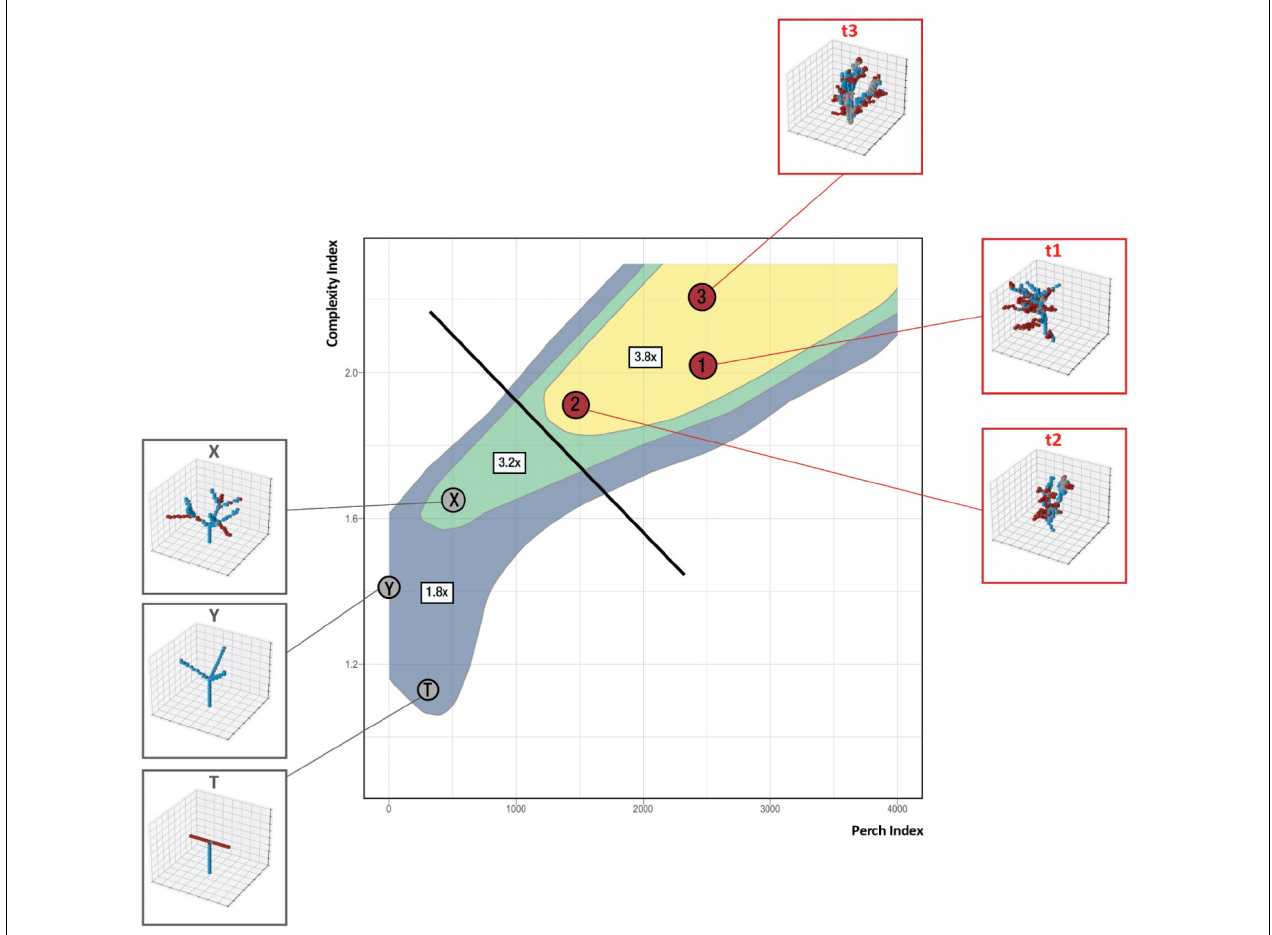
FIGURE 5 | Validation of measurement workflow through a comparison of the assessment routine outcomes and field observations of bird response to the same structural types.